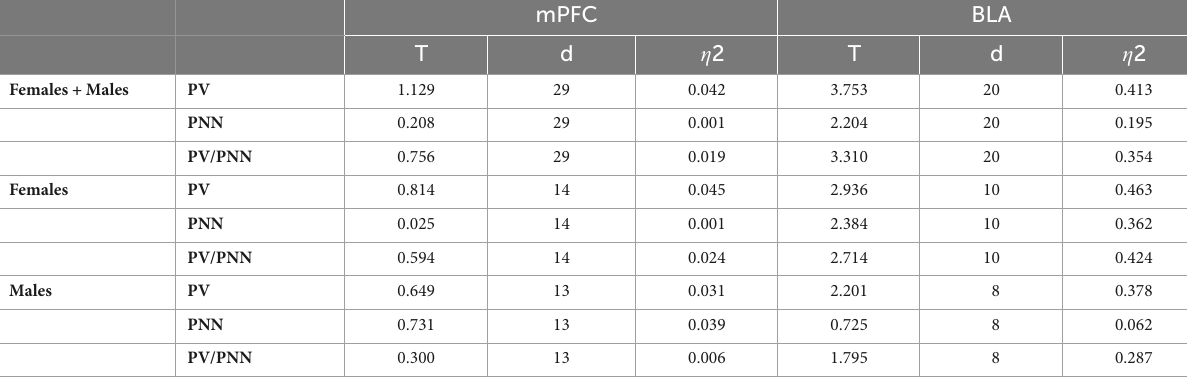
TABLE 3 Brain neuroplasticity changes in MIS vs. Saline, in females and